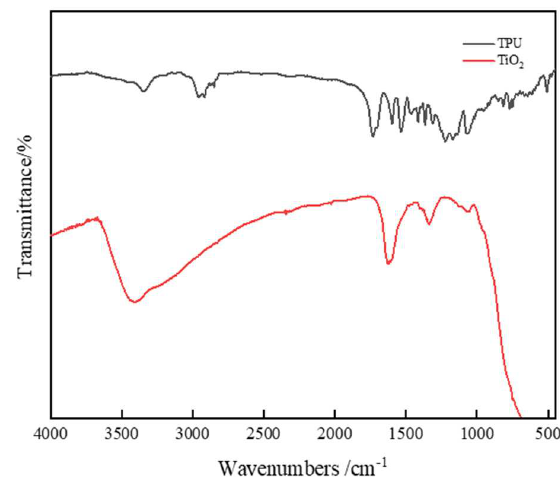
Figure 8. FTIR diagram of TPU and nano-TiO 2.